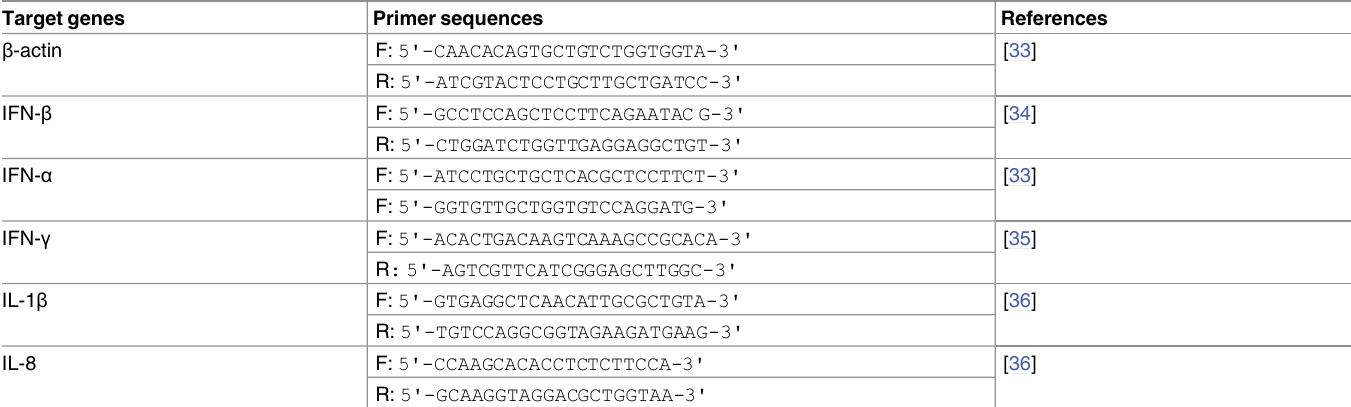
Table 1. Genes and primer sequences used for real-time PCR.